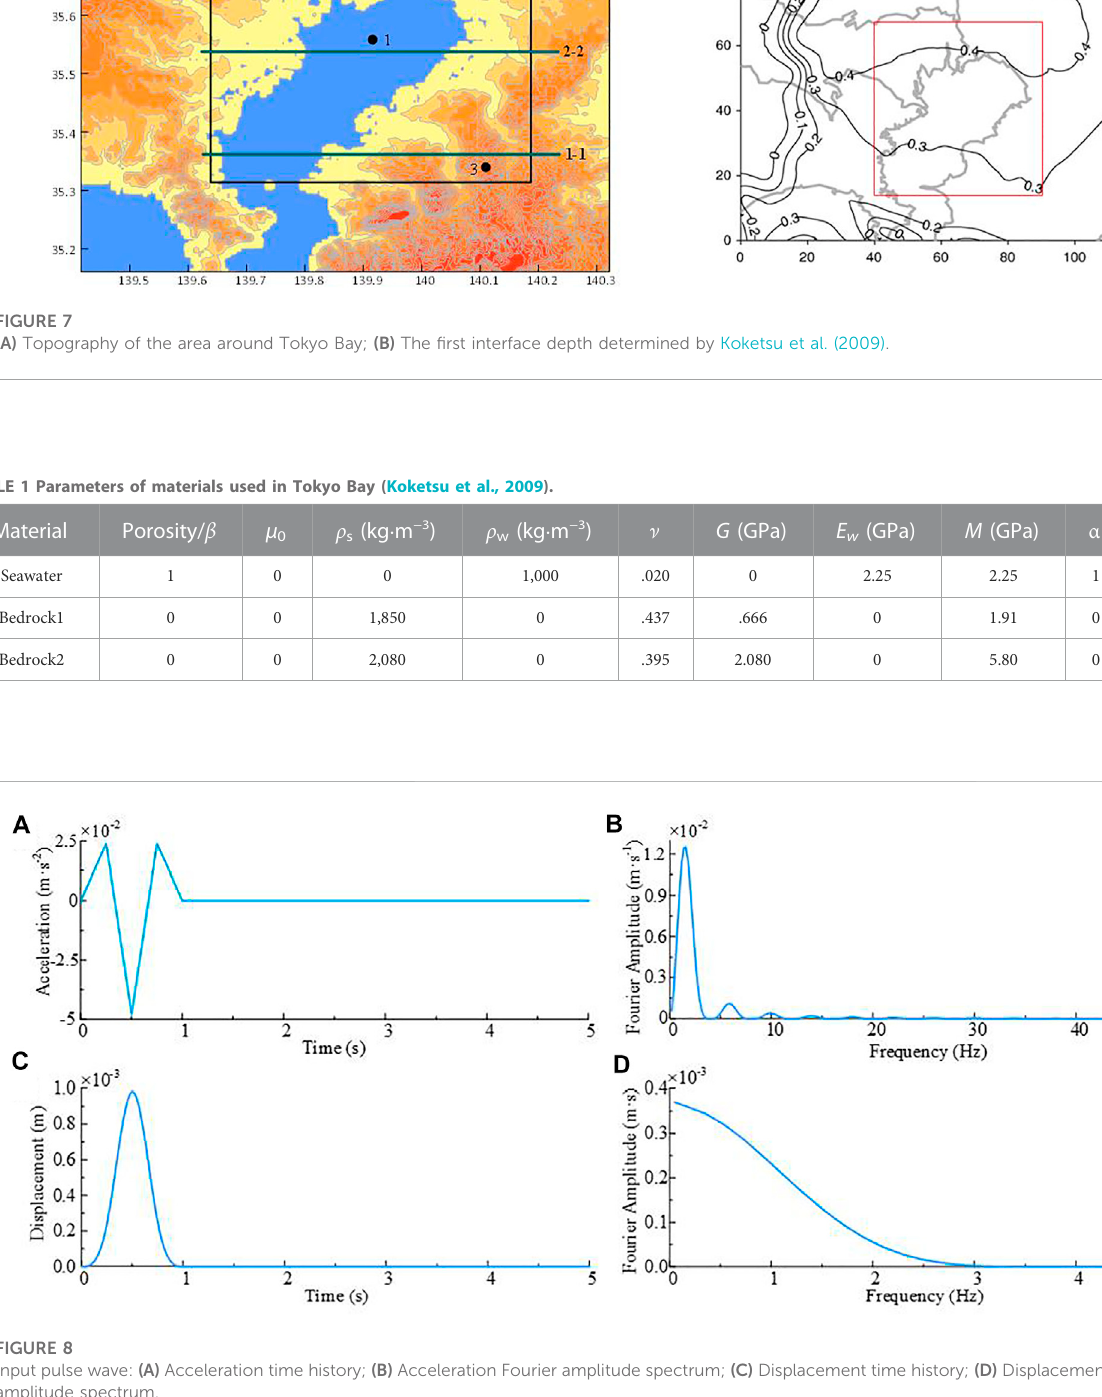
Frontiers in Earth